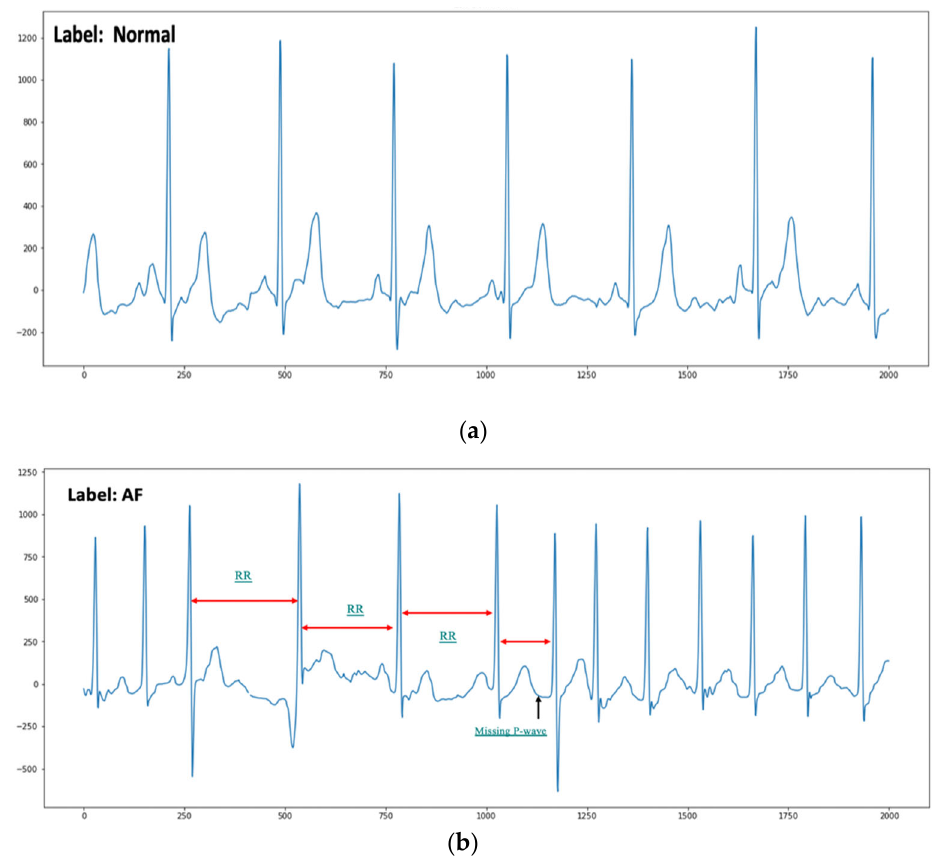
Figure 5. Examples of ( a ) normal and ( b ) AF ECG signals with irregular RR intervals and the absence of P-waves. Table 4. Statistics of the PhysioNet Challenge 2017